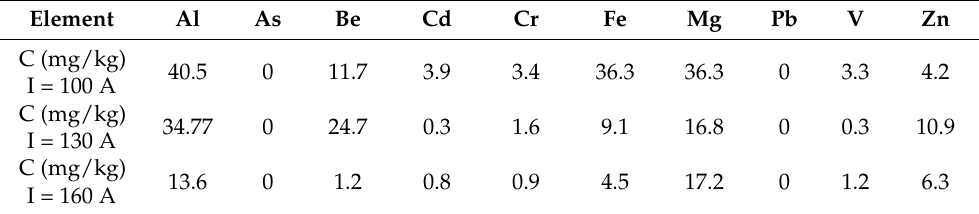
Table 4. Concentrations of elements present in the waste at different plasma currents obtained by ICP. Element Al